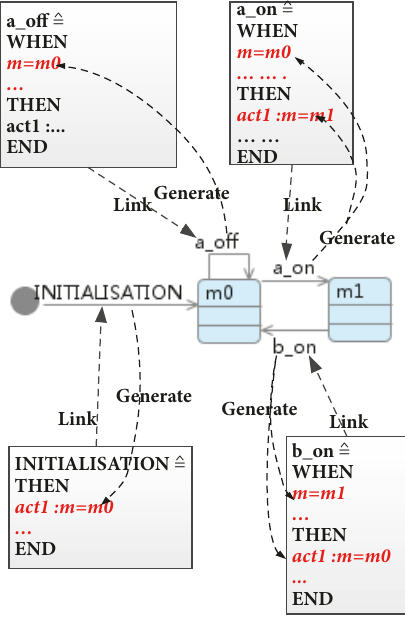
Figure 1: iUML-B state machine of Req